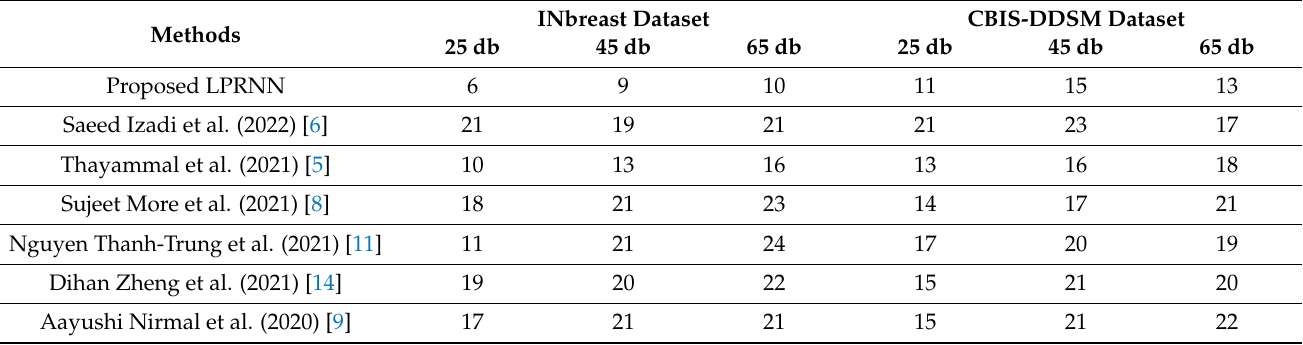
Table 3. Image noise removal comparison chart of proposed and state-of-art methods.